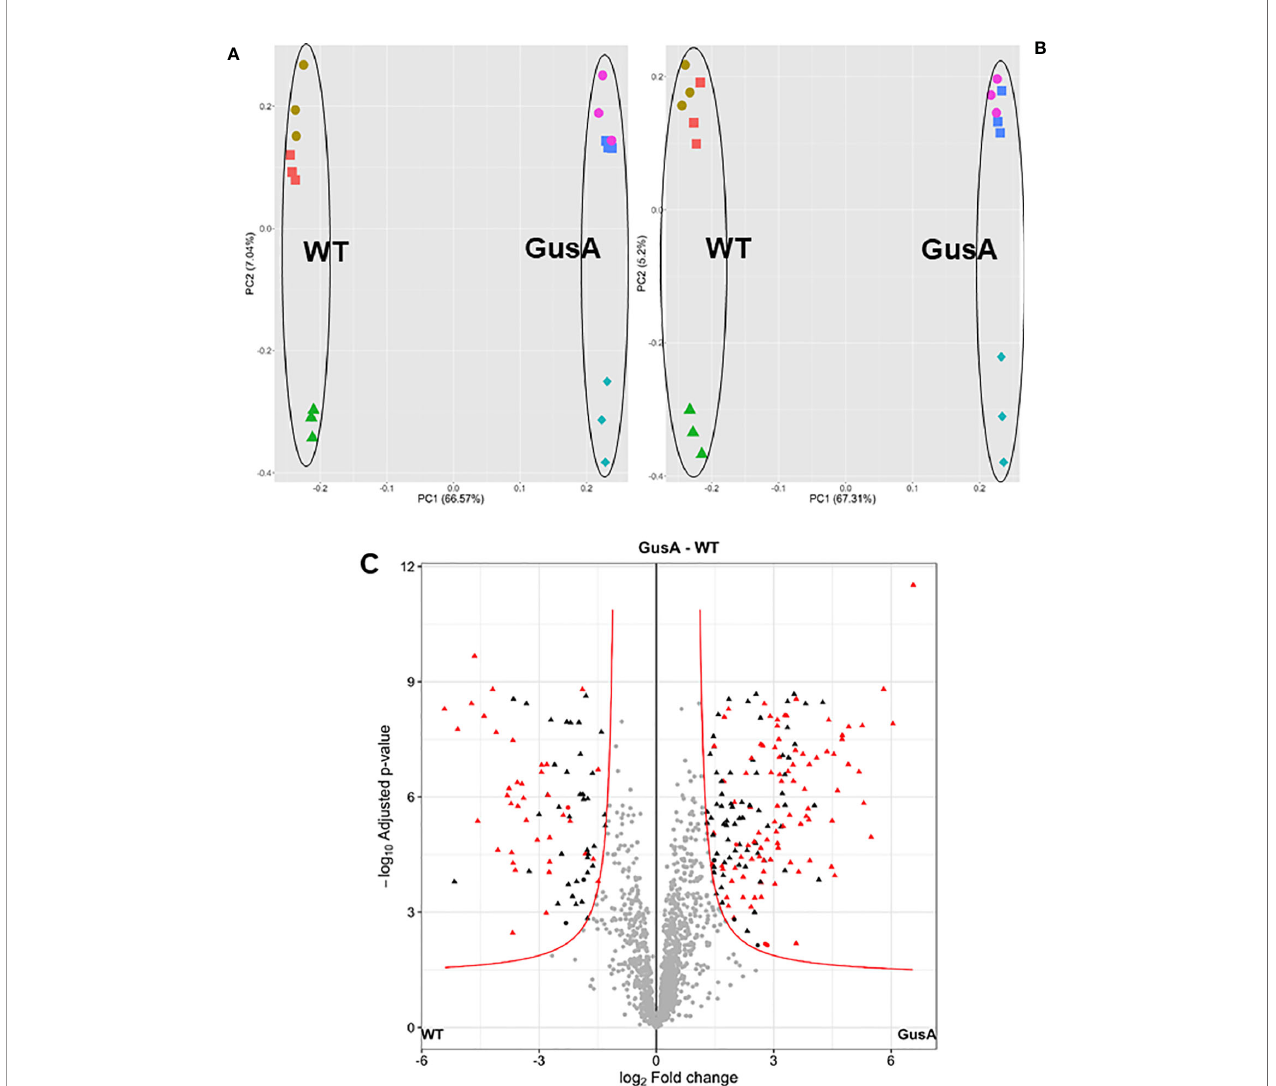
FIGURE 2 | Principal component analysis plots (A, B) and volcano plot (C) of proteome data set from G. lamblia trophozoites transfected with a plasmid containing E. coli glucuronidase A (GusA) and of not transfected, control trophozoites (WT). The principal component analysis plots show for each strain, all technical and biological (red square, brown circle, green triangle for WT; pink circle, blue square, turquoise diamond for GusA) replicates based on iiTop3 data (A) or iLFQ data (B) . The volcano plot (C) is based on iiTop3 data. Differential proteins identi fi ed by both iiTop3 and iLFQ algorithms are depicted in